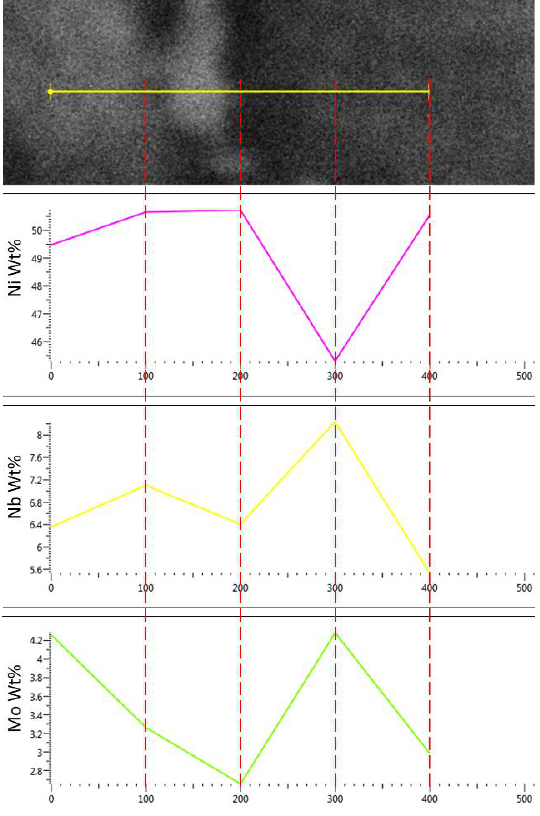
Figure 10. Microstructure of cellular IN718 after 10 h of aging and punctual EDS microanalysis in five positions along the marked line.